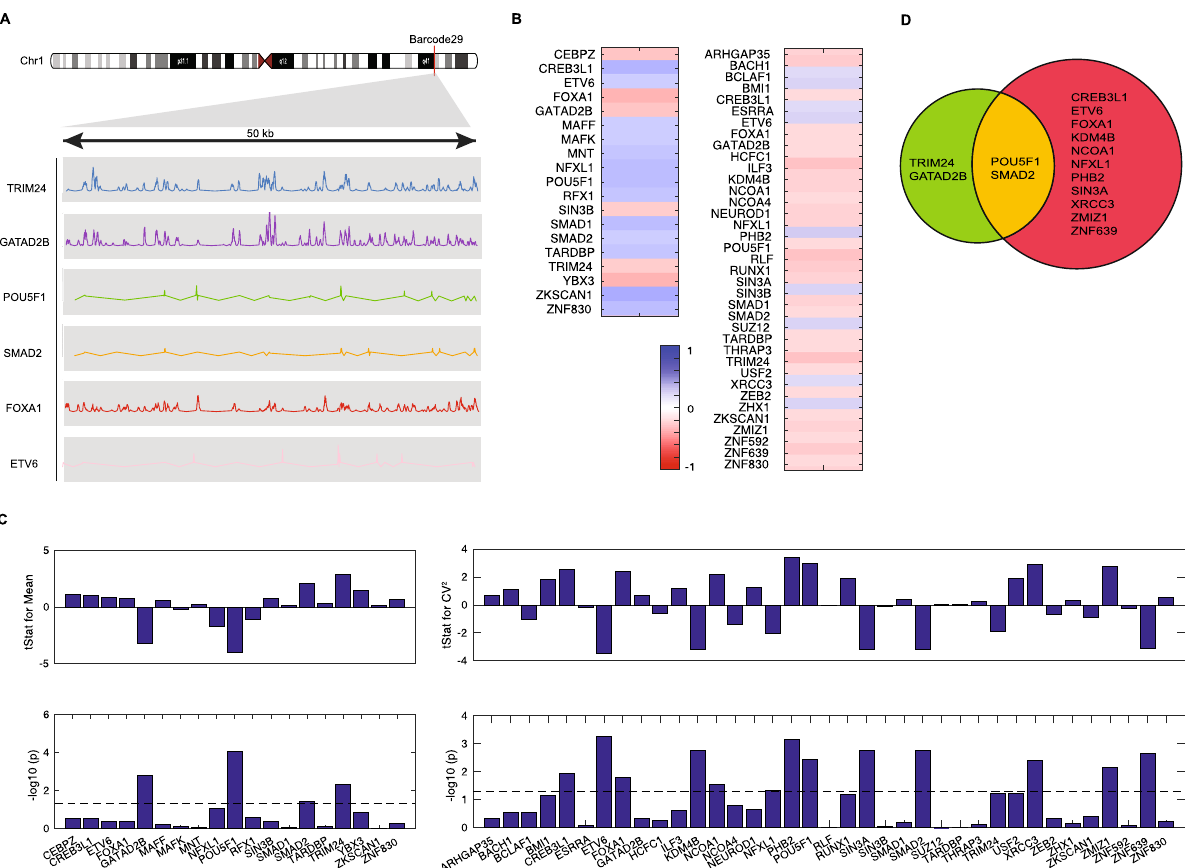
Figure 3. Identification of key transcription factors associated with reporter expression levels and noises using multivariate linear regression analysis. ( A ) View of the barcode 29 locus on chromosome 1. Genome coordinate of each barcode was obtained from conducting TRIP experiment. Six examples of normalized ChIP-seq signal profile of transcription factor surrounding the integration site of the barcode 29 were visualized for a domain of 50 kb. ( B ) The heatmap showing the correlation between the enrichment of transcription factors and reporter expression mean and noise. Transcription factors with Spearman’s rank-order correlation coefficient of more than 0.2 were selected from over 200 tested transcription factors. ( C , D ) To understand the relationship between the enrichment of TF and the expression levels ( C ) and noise ( D ) of reporter in an integrative way, we selected transcription factors showing a significant correlation in ( B ) to fit multivariate linear regression model. Features with a significant level above the threshold or dashed line (p < 0.05) contributed significantly to the model. ( E ) A Venn diagram listing transcription factors contributing to reporter expression mean (green) and noise